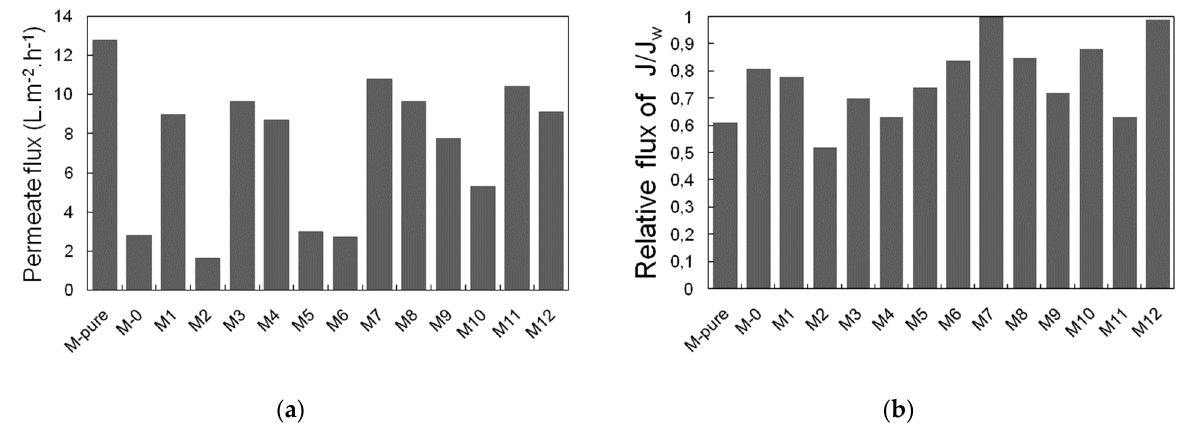
Figure 9. ( a ) Permeate flux variation of synthesized membrane treating ammonia chloride as feed solution and ( b ) relative flux of membrane after filtration.